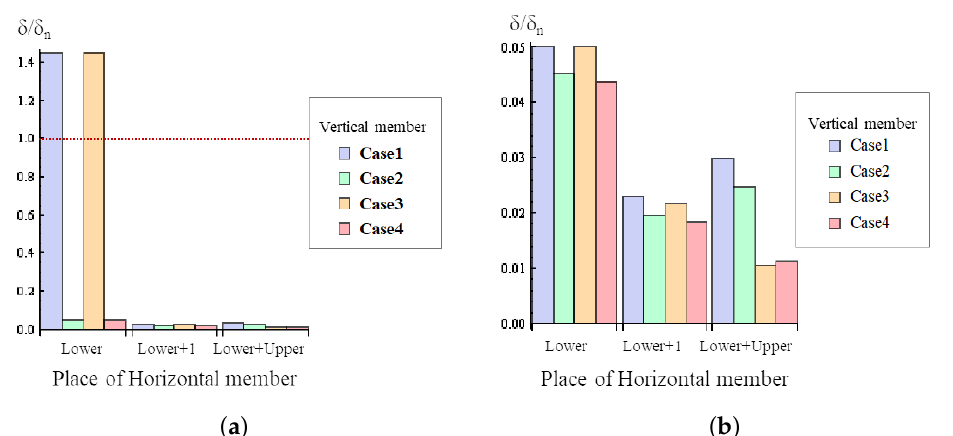
Figure 14. Summarized central displacement in three units model according to the reinforcing layouts: